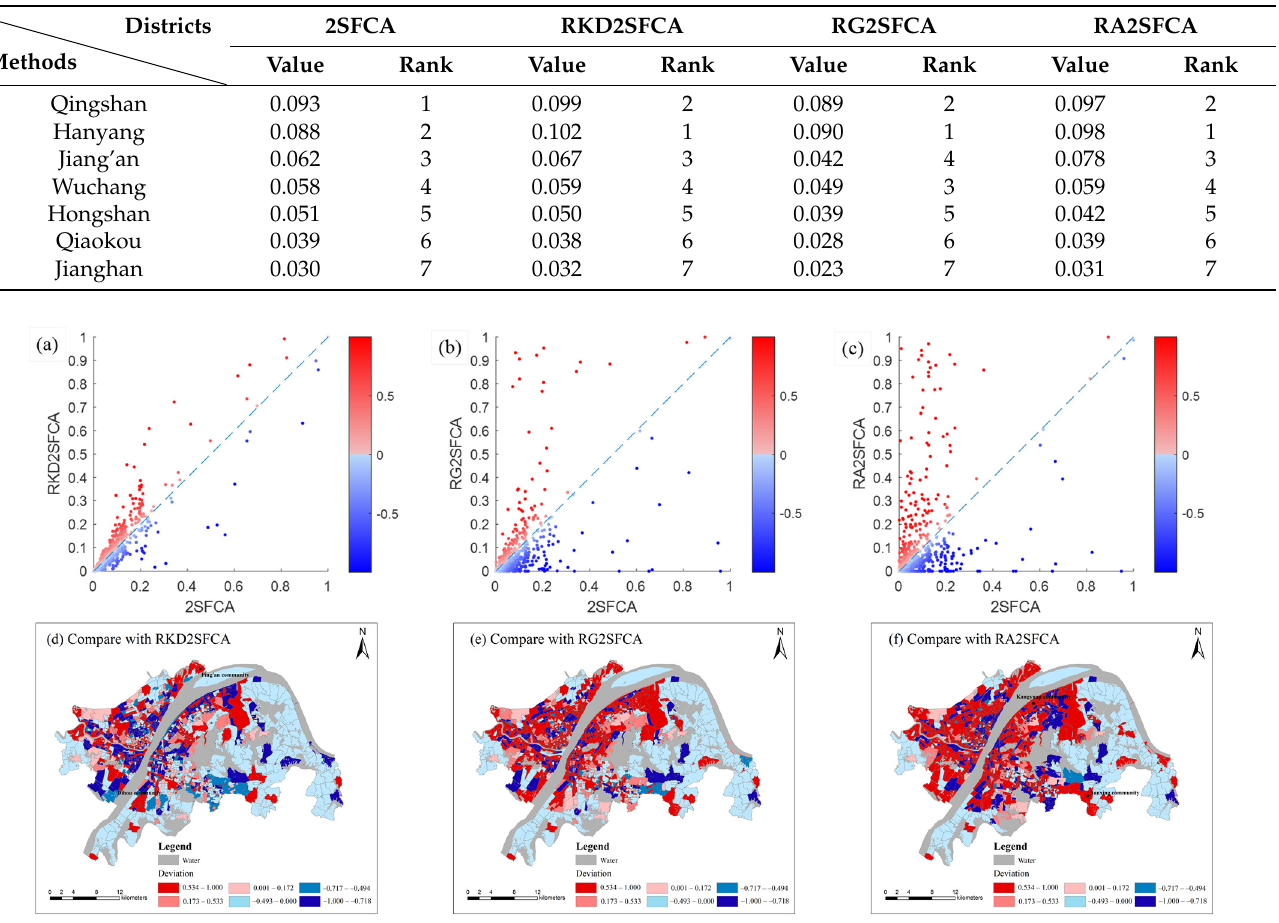
Figure 4. Comparison of 2SFCA method with RKD2SFCA ( a ), RG2SFCA ( b ) and RA2SFCA ( c ). The first row is the comparison of over/underestimation among methods. The second row is the over/underestimated spatial distribution map of 2SFCA method compared with RKD2SFCA ( d ), RG2SFCA ( e ) and RA2SFCA ( f ).